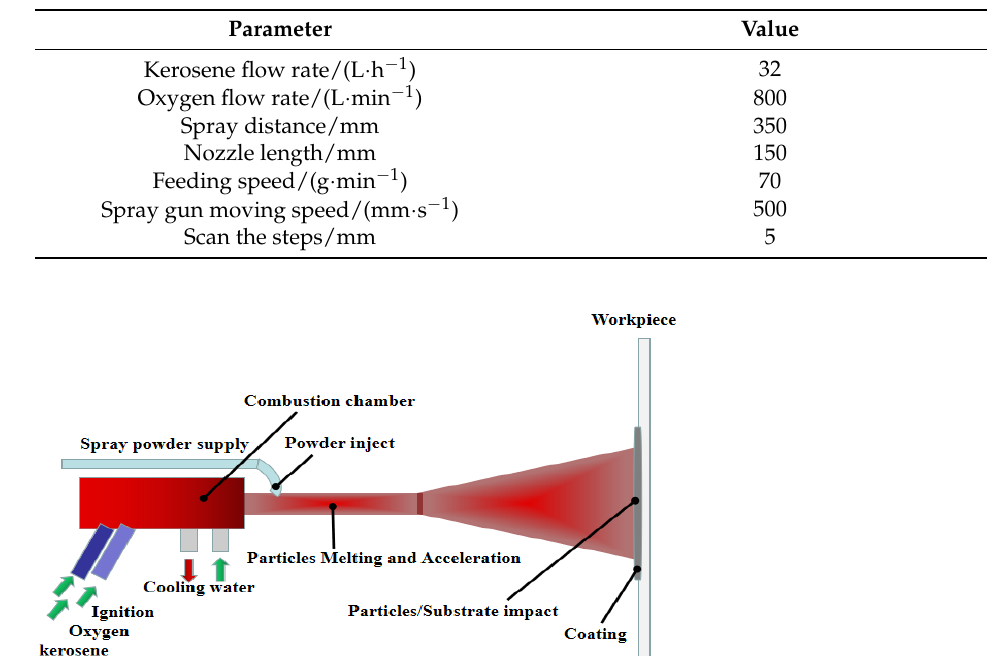
Table 2. HVOF Spraying process parameters.